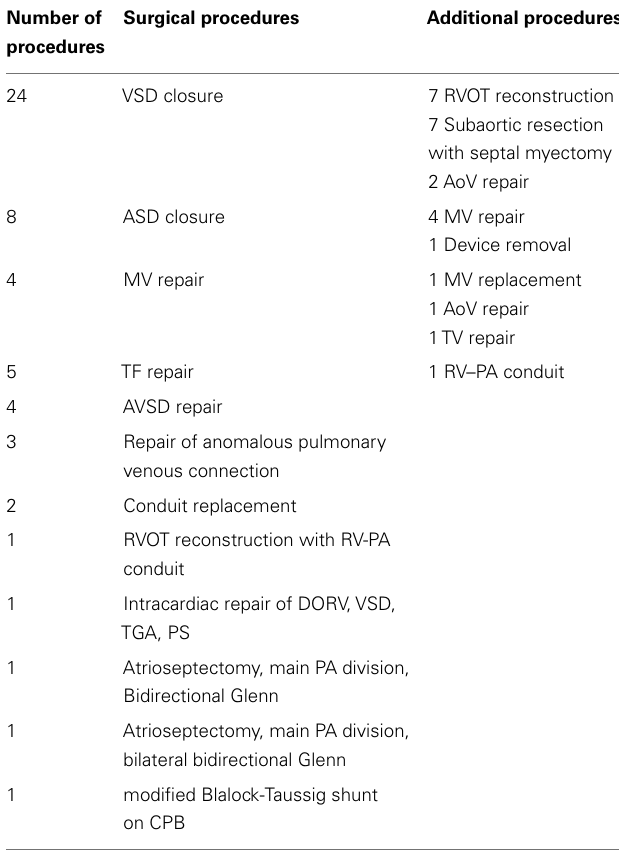
Table 2 | List of surgical procedures